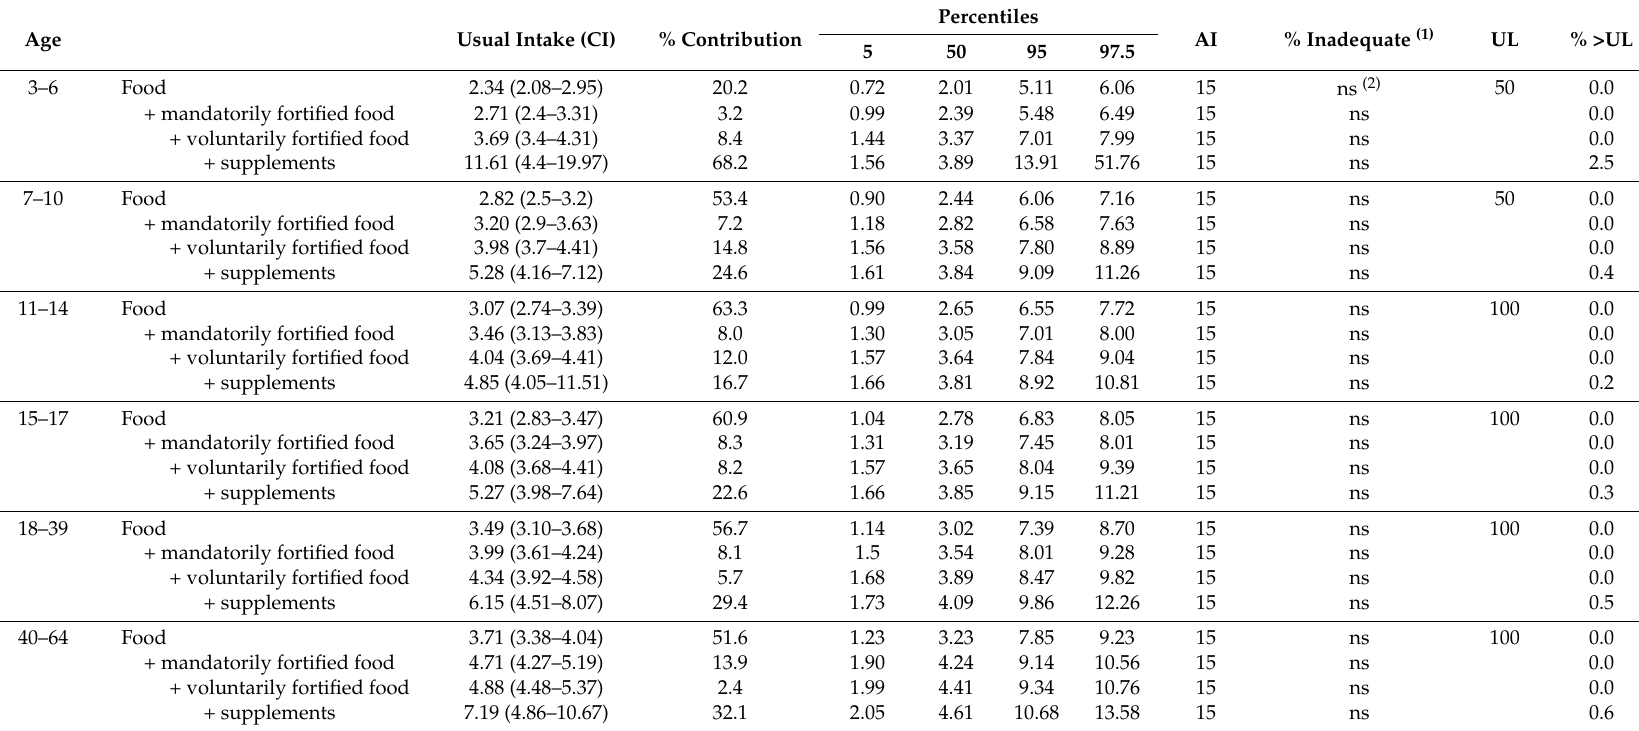
Table 5. Usual intake of vitamin D ( µ g/day) from food, fortified food and supplements in Belgian men (3–64 years), Belgian study on the intake of vitamins A, D, E and K (VITADEK-study) 2015. AI, adequate